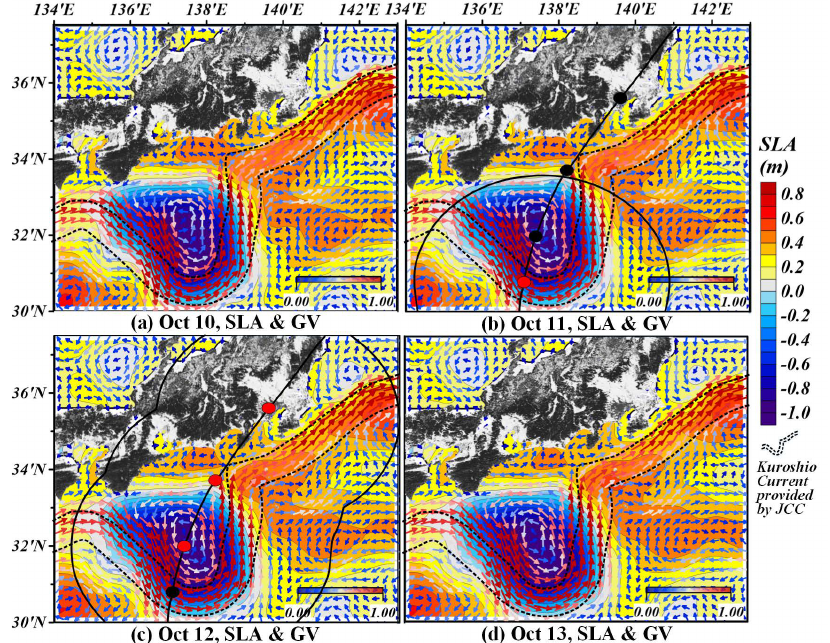
Figure 6. Validation of the daily Kuroshio mainstream between AVISO (red arrows) and JCC (black dotted line) data and tracking cyclonic and anticyclonic eddy in terms of SLA; ( a ) 10 October, ( b ) 11 October, ( c ) 12 October, and ( d ) 13 October with the typhoon track and intensity,